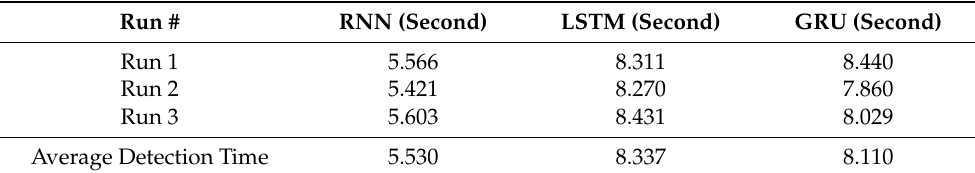
Table 11. Detection Time of RNN, LSTM, and